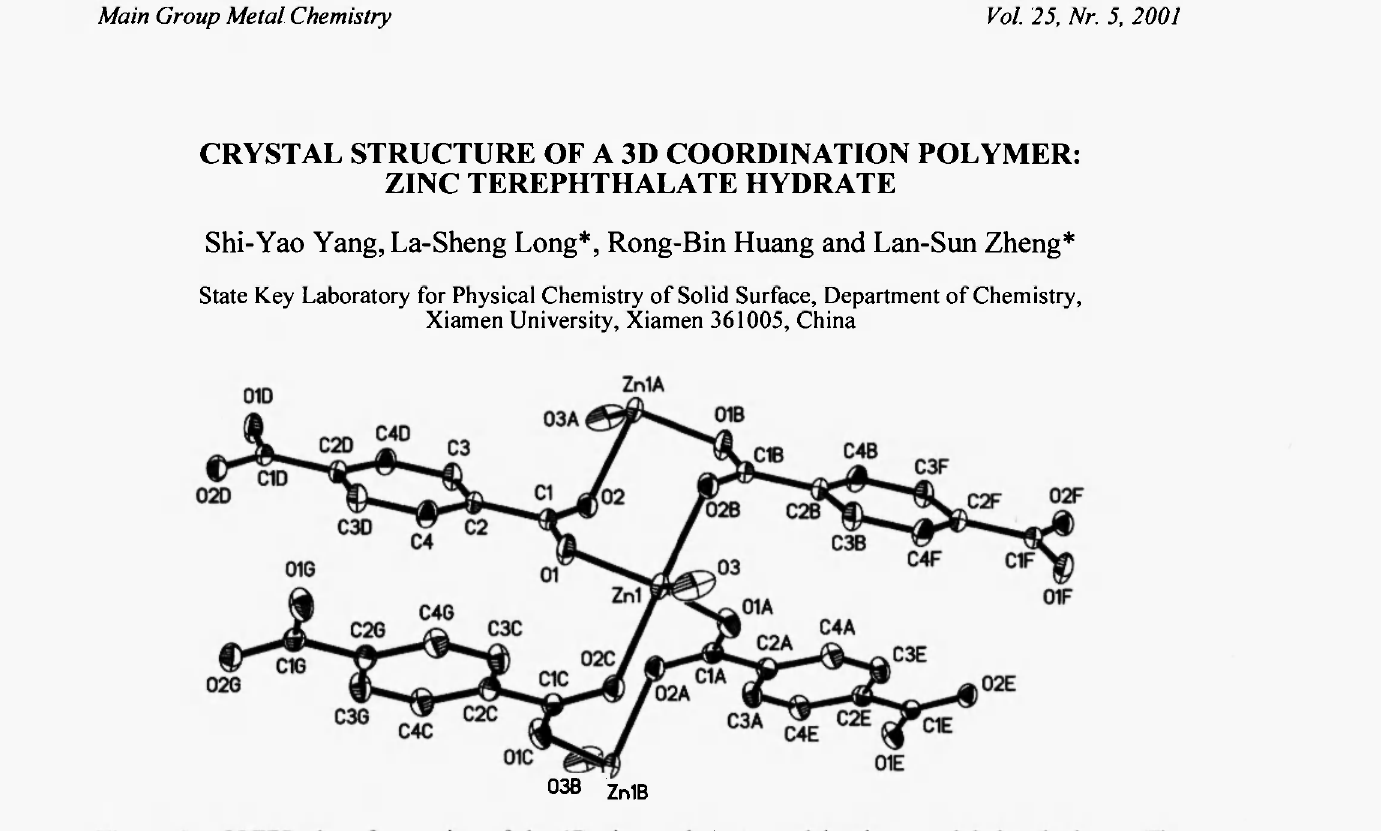
Figure 1. ORTEP plot of a portion of the ID zigzag chain formed in zinc terephthalate hydrate. The diagram was drawn at the 50% probability level and hydrogen atoms have been omitted for clarity. Selected bond distances and angles: Znl-Ol 1.9446(17), Znl-03 1.978(3), Znl-026 2.1829(17) Ä; Ol-Znl-Ola 138.68(12), 01-Znl-03 110.66(6), 01-Znl-026 88.43(7), 03-Znl-02b 87.14(5), 01-Znl-02c 93.58(7), 02A-Zn 1 -02c 174.28(9)°. Symmetry transformation: a = - x, y, - z+5/2, b = x, -y+1, z+1/2, c = - x, - y+1, -z+2.